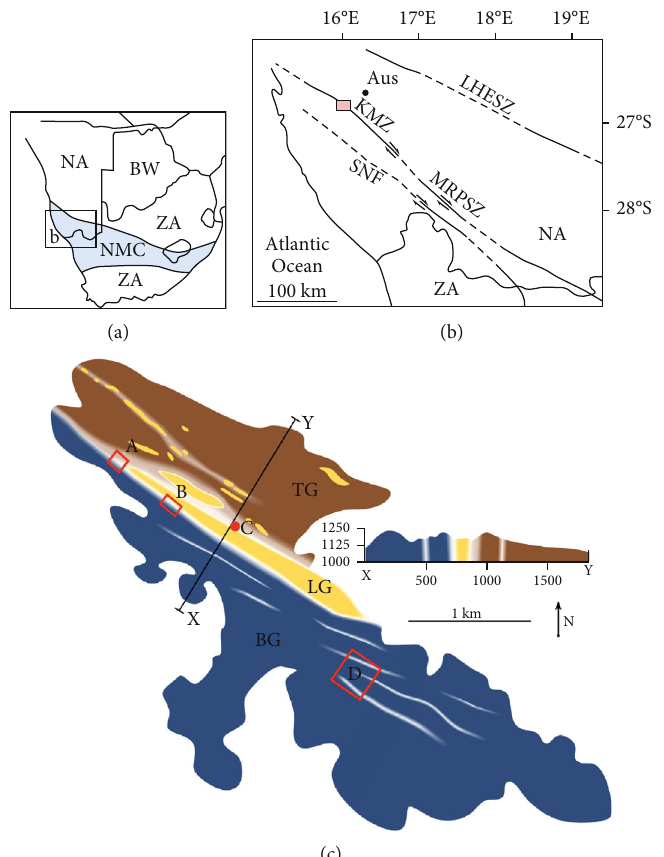
Figure 1: Geological setting of the Kuckaus Mylonite Zone (KMZ) in the Namaqua Metamorphic Complex (NMC) of southern Africa (a). The KMZ is part of the Marshall Rocks-Pofadder shear zone system (MRPSZ), subparallel to the Southern Namaqua Front (SNF) and the Lord Hill - Excelsior Shear Zone (LHESZ) (b). In the study area, the KMZ is exposed over a 2 by 5 km area (shape of mapped area is a function of Quaternary sands coverage), with Tsirub Gneiss (TG) in the NE, the main leucogranite (LG) bodies in the middle, and biotite gneiss (BG) in the SW (c). Strain is heterogeneously distributed over 1-2 km (same strain gradient key as in Figure 2). Red boxes show locations of areas A-D in Figure